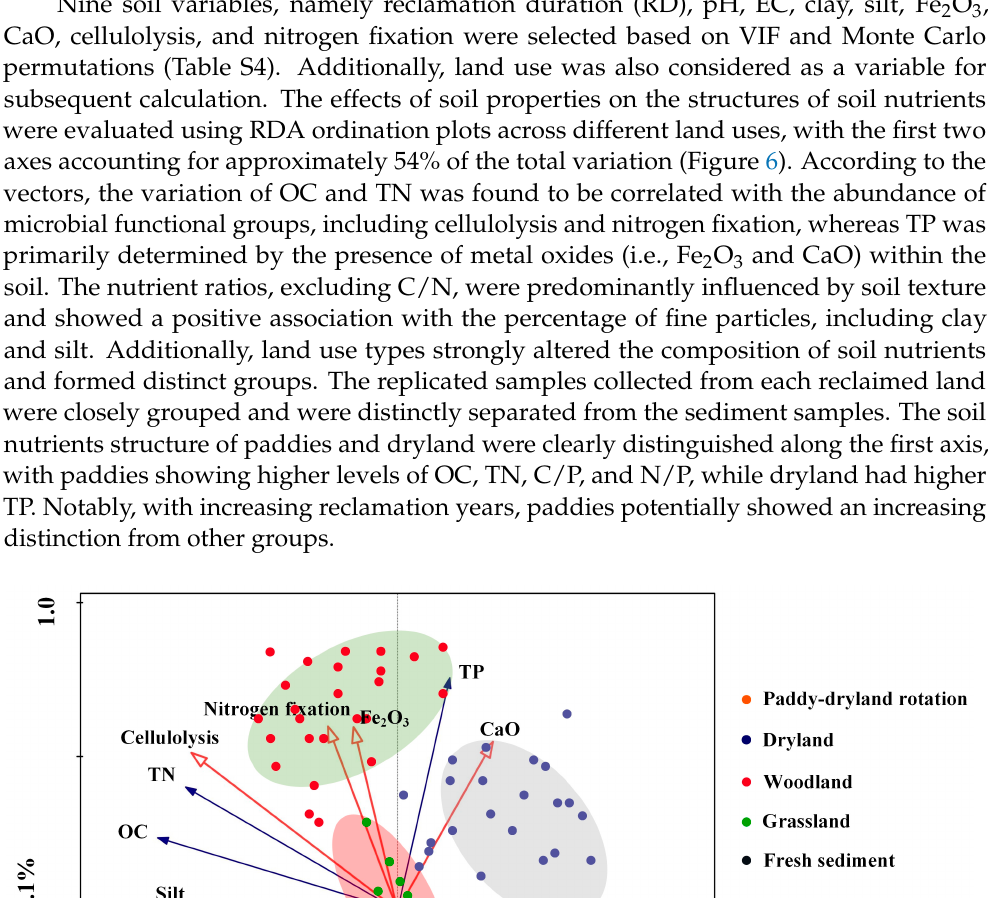
Figure 5. Linear correlations between soil nutrients and eco-stoichiometric ratios ( a – c ) and interac- tion relationships of various nutrients ( d – f ). OC, organic carbon; TN, total nitrogen; TP, total phos- phorus.